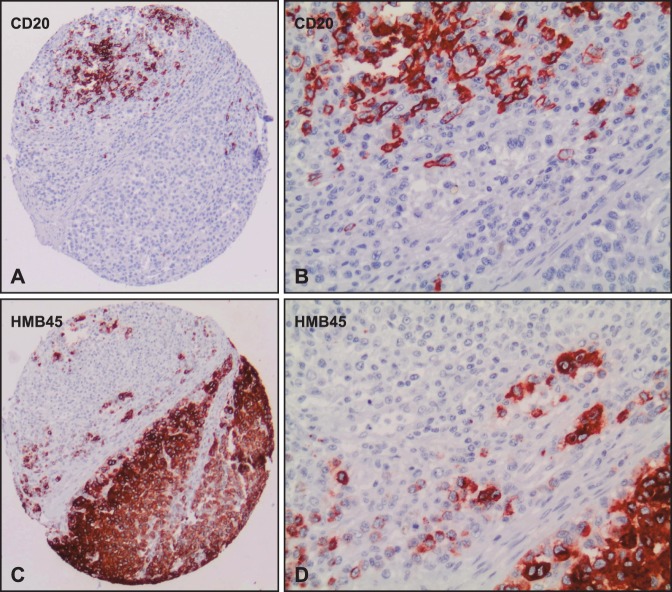
High resolution images of case no. 137 on the tissue microarray.Serial sections of the tissue microarray (TMA 1) was immunohistochemically stained with CD20 (Panel A, B) and HMB45 (Panel C, D) to show CD20 positive B-lymphocytes within and adjacent to melanoma cells (case no. 137).